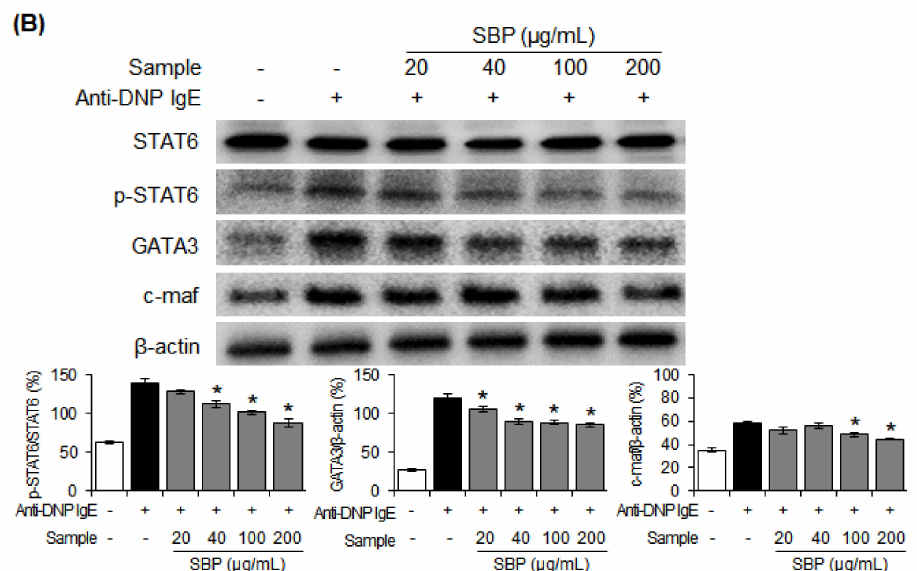
Figure 8. Effect of SBP extract on the protein expression of transcription factors related to the differen- tiation of ( A ) Th1 and ( B ) Th2 cells in anti − DNP IgE-sensitized RBL − 2H3 cells. Data are expressed as mean ± SEM. Significantly different from the LPS − treated group (* p < 0.05). SBP, sword bean pod. STAT1, signal transducer and activator of transcription; T-bet, T-box transcription factor TBX21; IRF1, interferon regulatory factor 1; GATA3, GATA binding protein 3; c-maf, transcription factor.